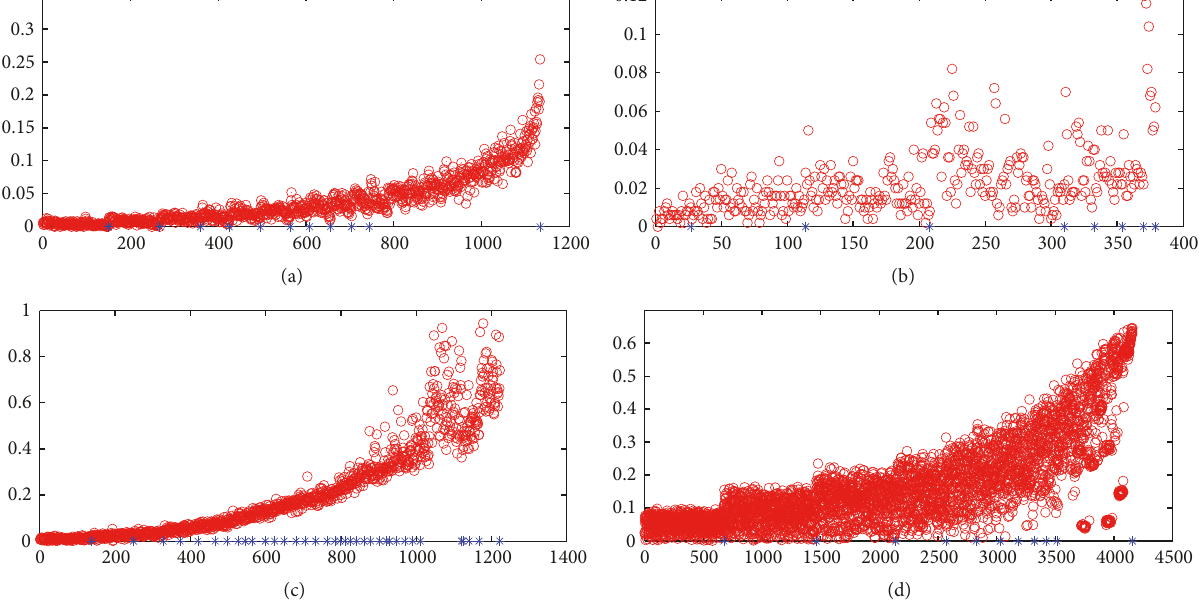
Figure 6: The average probability of each node to be informed on (a) Email-URV, (b) Netsci, (c) PolBlogs, and (d) Ca-GrQc, respectively. The rumors are more likely to reach higher layer